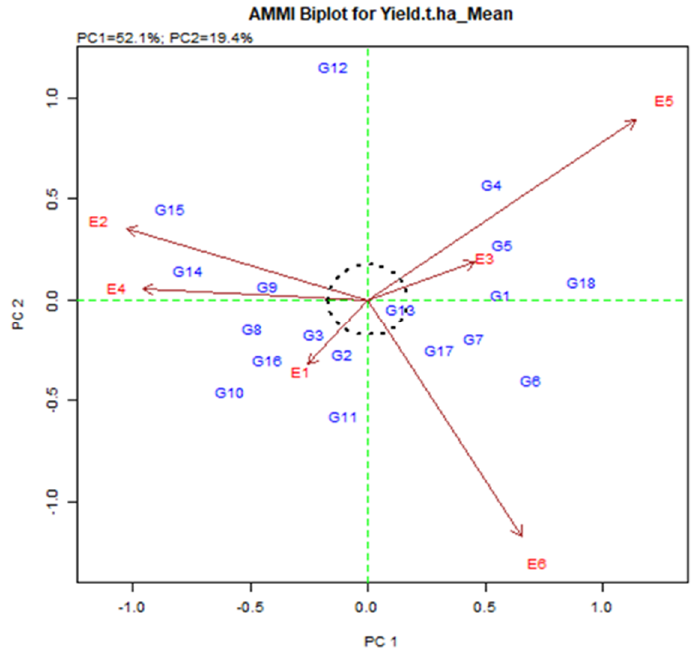
Figure 3. AMMI 2 biplot for grain yield (t/ha) exhibiting the interrelation of IPCA2 against IPCA1 scores of eighteen elite rice genotypes in six environments in Bangladesh.